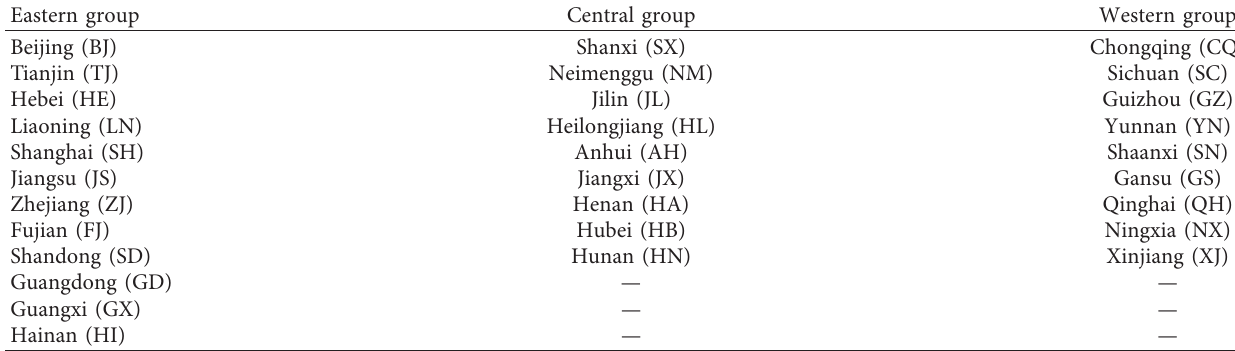
Table 2: The regional division of China in this study.